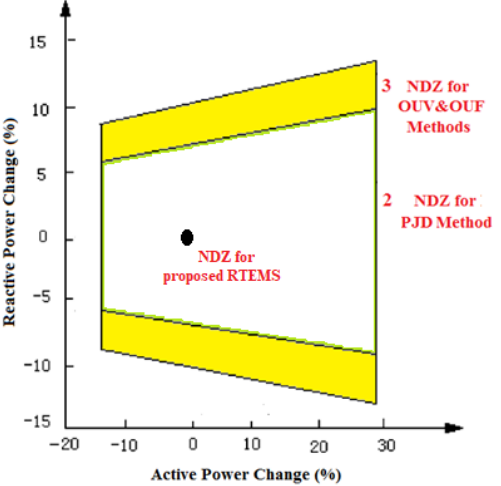
Figure 9. Assessing NDZs for proposed and conventional methods.